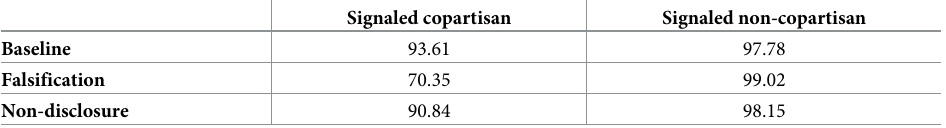
Table 1. Share of participants who believed their partner’s signaled identity by the identity signaled, across experi- mental